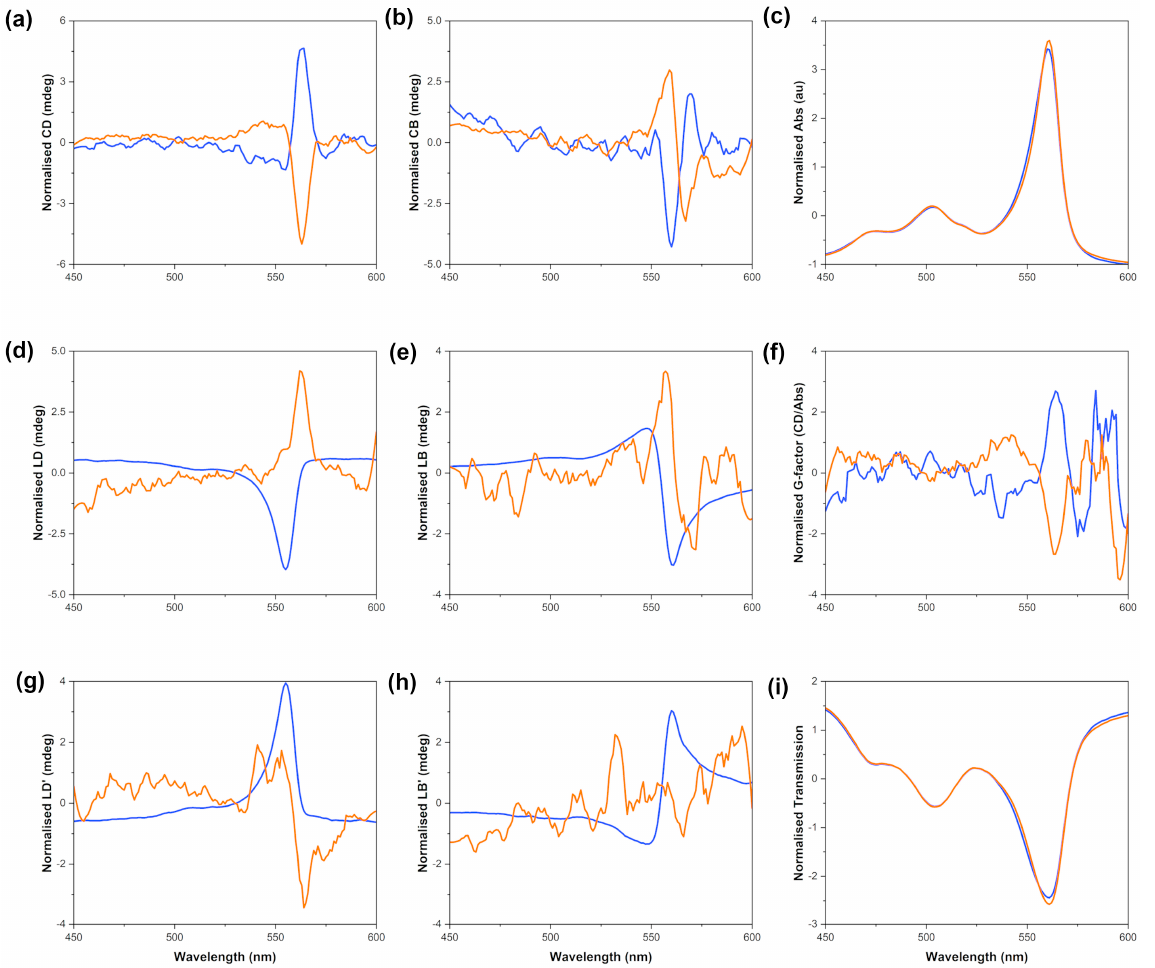
Figure 6. S0271 J -aggregates scanned on the MMP; J -aggregates assembled by stirring 25 µ M solutions Figure 6. S0271 J- aggregates scanned on the MMP; J -aggregates assembled by stirring 25 µM solu- in Milli-Q water (pH 7.12, 18.2 Ω cm − 1 ) CW (orange) and CCW (blue) for 16 h before aliquoting, tions in Milli-Q water (pH 7.12, 18.2 Ω cm − 1 ) CW (orange) and CCW (blue) for 16 h before aliquot- recorded at 24 ◦ C. The natural optical activity is highlighted in graph ( a ), ( b ) circular birefringence, ing, recorded at 24 °C. The natural optical activity is highlighted in graph ( a ), ( b ) circular birefrin- gence, ( c ) absorbance, ( d ) linear dichroism, ( e ) linear birefringence, ( f ) g abs , ( g ) 45° linear dichroism, ( c ) absorbance, ( d ) linear dichroism, ( e ) linear birefringence, ( f ) g abs , ( g ) 45 ◦ linear dichroism, ( h ) 45 ◦ ( h ) 45° linear birefringence, ( i ) transmission. The data shown in this figure are the average of four linear birefringence, ( i ) transmission. The data shown in this figure are the average of four scans, scans, smoothed and normalised using Z-scores. smoothed and normalised using